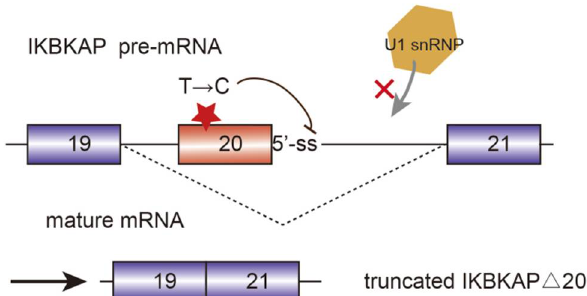
Figure 3. Mutated i-kappa-B kinase complex associated protein (IKBKAP) plays a role in the de- velopment of familial dysautonomia (FD). The single nucleotide mutation from T to C disrupts the interaction between pre-mRNA and U1 snRNP and induce the exon 20 exclusion.